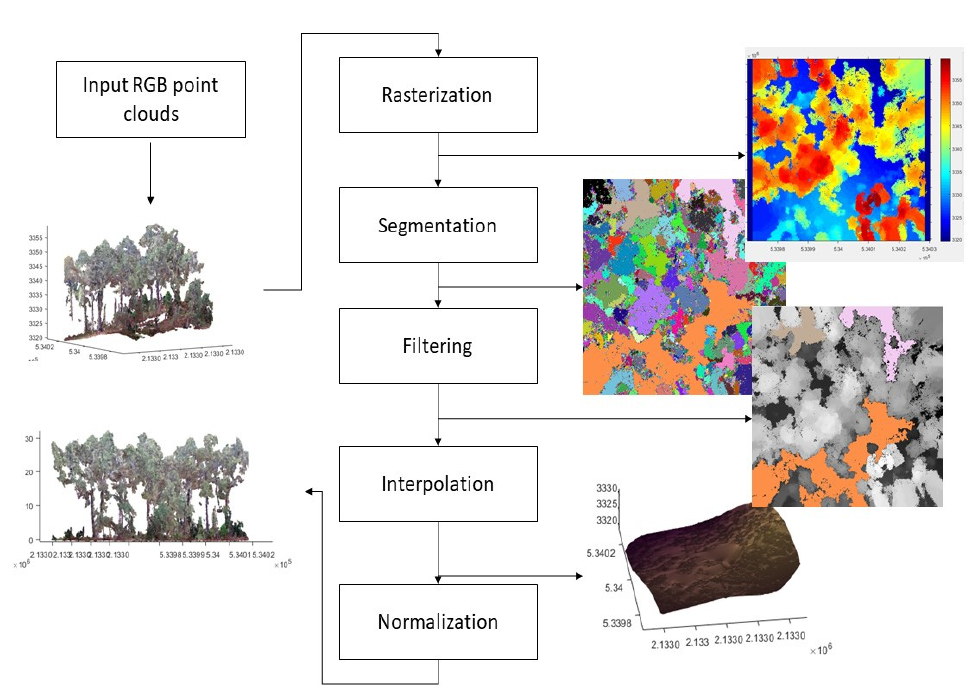
Figure 5. Flow diagram for the normalization of the point cloud [39].